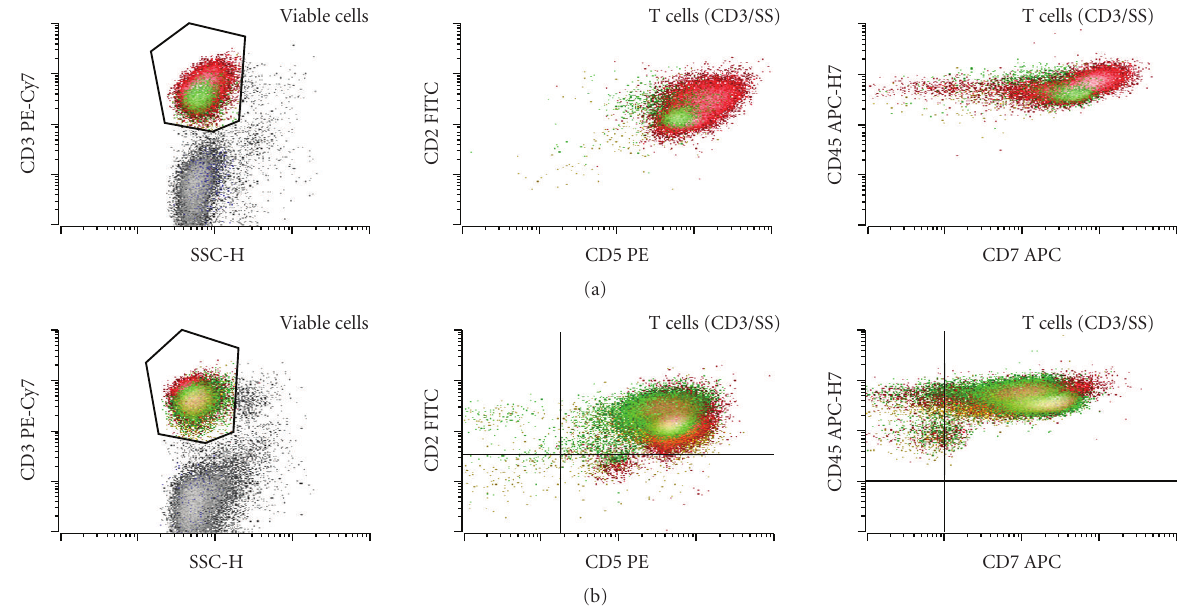
Figure 4: (a) CHL reactive background T cells often demonstrate a range of specific reactive features including increased levels of CD2, CD5, CD7, and CD45 that are particularly noticeable on the CD4-positive T cells (red) compared to CD8-positive T cells (green). Also note increased CD4:CD8 ratio among the T cells that is often, but not always, observed in CHL cases. (b) No such changes are seen in a patient with reactive follicular